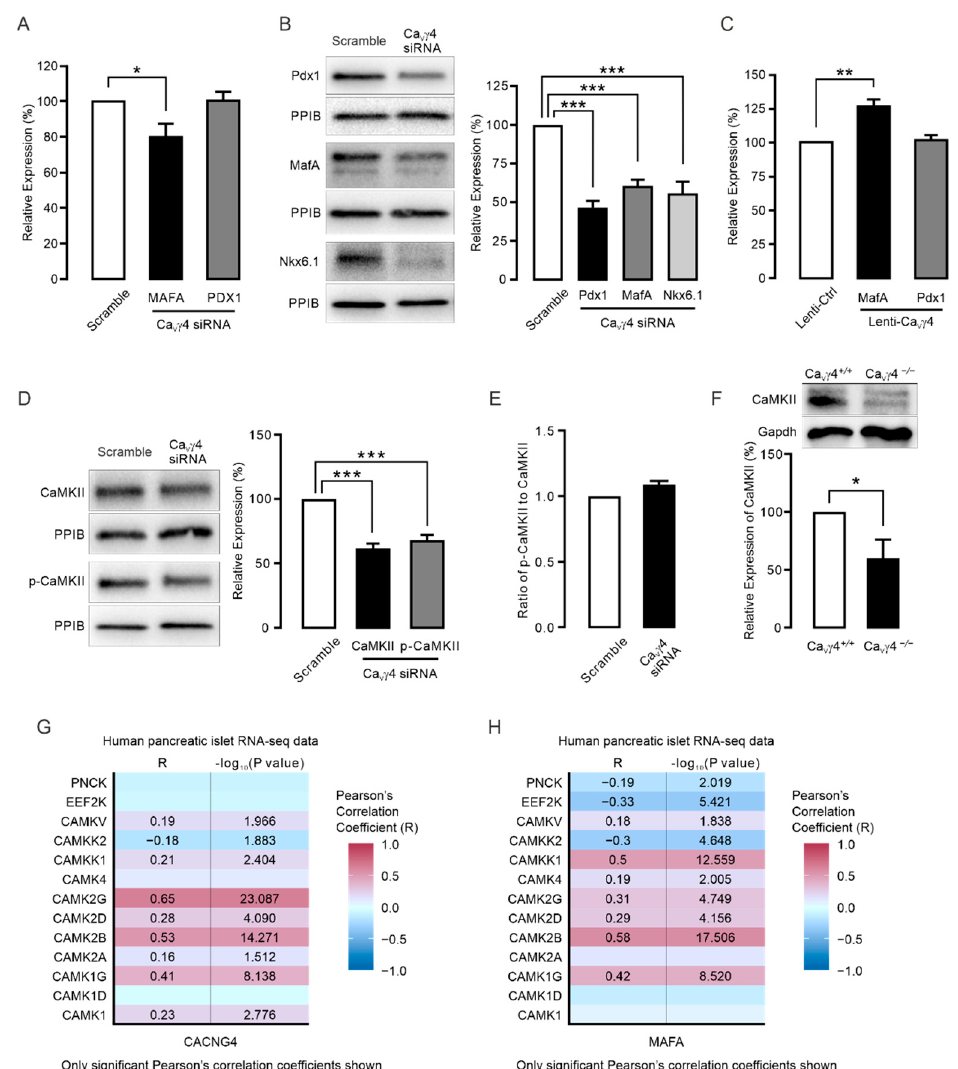
Figure 3. CaMKII expression is downregulated in Ca V γ 4-silenced beta-cells: ( A ) PDX1 and MAFA mRNA expression in Ca V γ 4-silenced human islets. n = 4 ( PDX1 ) and 6 ( MAFA ) donors. * p = 0.031. ( B ) Pdx1, MafA and Nkx6.1 immunoblotting and means of expression in Ca V γ 4-silenced INS-1 832/13 cells. n = 4, *** p < 0.001. ( C ) As in ( A ) but in Ca V γ 4-overexpressed INS-1 832/13 cells. n = 4, ** p = 0.002. ( D ) Decreased CaMKII and phosphorylated-CaMKII expressions in Ca V γ 4-silenced INS-1 832/13 cells. n = 4, *** p < 0.001 for both. ( E ) Ratio of protein expressions in ( D ) of phosphorylated- CaMKII to CaMKII. n = 4, p > 0.05. ( F ) CaMKII protein levels in Ca V γ 4 +/+ and Ca V γ 4 − / − mouse islets. n = 4 mice each. * p < 0.05. ( G ) Pearson’s correlation coefficients (R) calculated by mRNA expression (RNA-seq, human islets) between the CAMK family genes and CACNG4 . n = 188 human donors. ( H ) As in ( G ) but between CAMK family genes and MAFA . n = 188 human donors. Data are presented as Mean ± SEM and were analyzed with one-way ANOVA with Dunnett’s multiple comparisons test ( A – D ); and two-tailed Student’s t -test ( E – H ). See Supplementary Table S1 for the details of the human donors utilized for the experiment in this study.